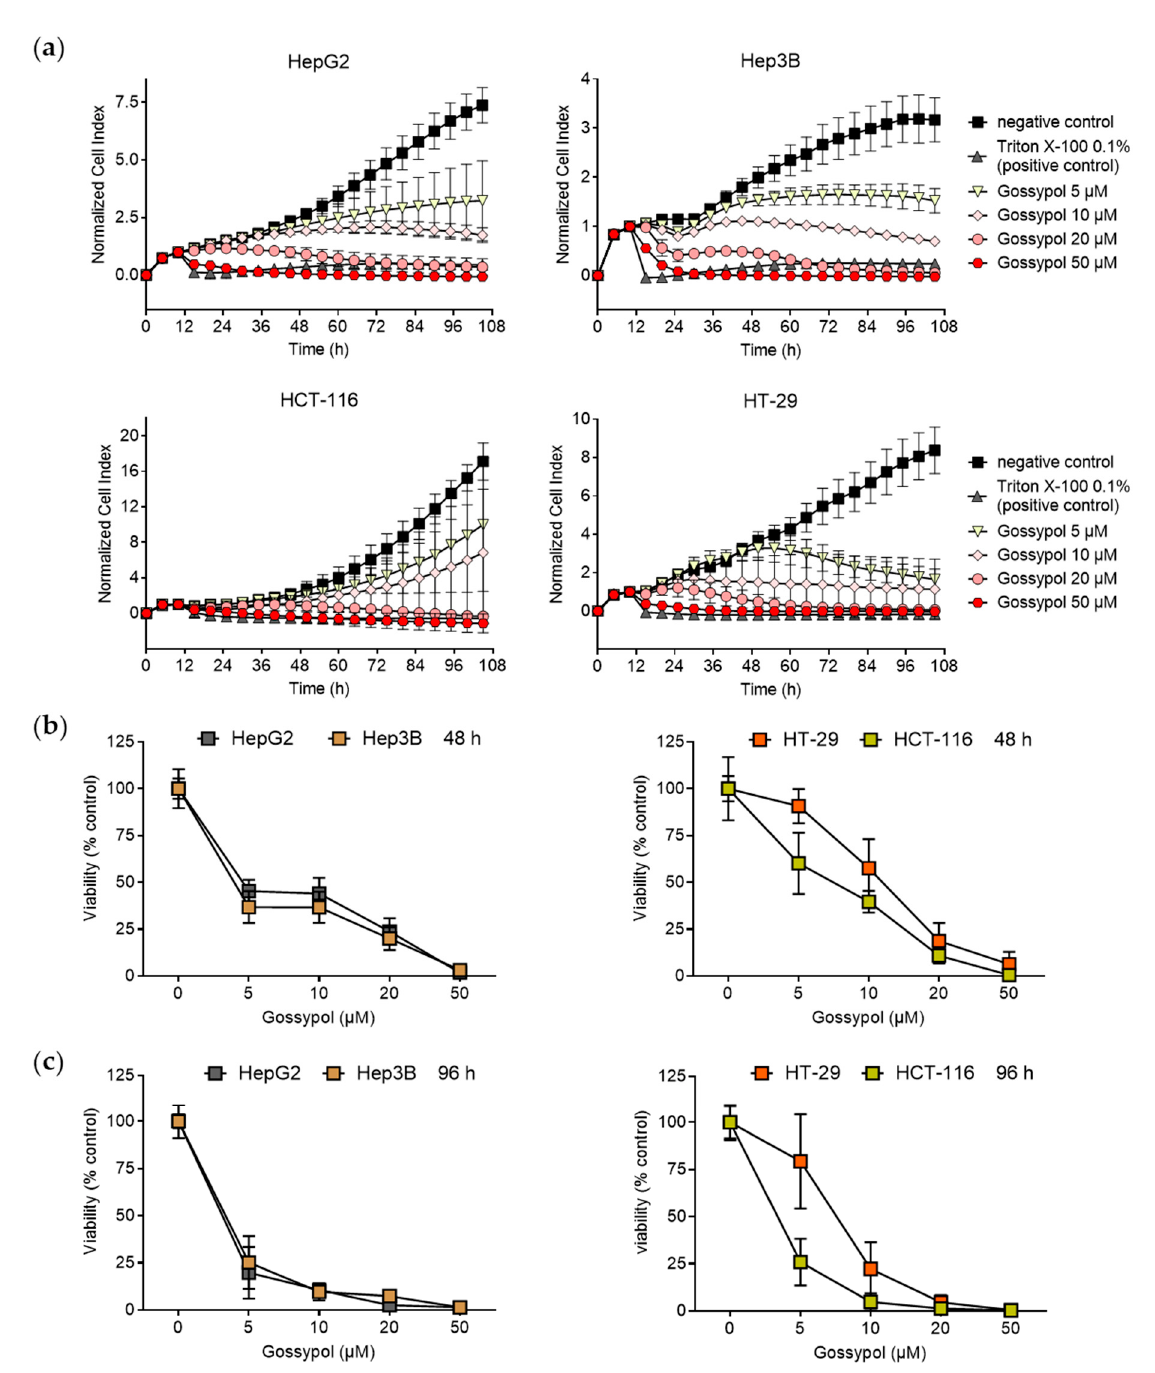
Figure 1. Reduced proliferation and viability of different hepatoma and colon carcinoma cell lines treated with gossypol. ( a ) Real-time proliferation curves. After 10 h incubation, cells were treated with different concentrations of gossypol (5 µM, 10 µM, 20 µM, 50 µM) or culture medium (negative control) and monitored for an additional 96 h. As control for complete inhibition of cell proliferation, 0.1% ( v / v ) Triton X-100 (positive control) was used. Cellular impedance was measured over the entire observation time using the xCELLigence TM SP device (Agilent Technologies Inc., Santa Clara, CA, USA) and calculated by the RTCA Software Pro (2.3.2.). All CI values were normalized at 10 h before treatment started. Normalized CI values are displayed in intervals of 5 h. The mean values ± SD of three independent experiments are depicted. IC 50 values for treatment duration of 72 h and 96 h were calculated with RTCA Software; HepG2, IC 50 (72 h): 6.30 µM (SD = 1.73 µM), IC 50 (96 h): 4.35 µM (SD = 2.10 µM); Hep3B, IC 50 (72 h): 6.87 µM (SD = 1.02 µM), IC 50 (96 h): 5.83 µM (SD = 0.81 µM); HCT-116, IC 50 (72 h): 3.61 µM (SD = 1.54 µM), IC 50 (96 h): 5.36 µM (SD = 2.87 µM), HT-29, IC 50 (72 h):